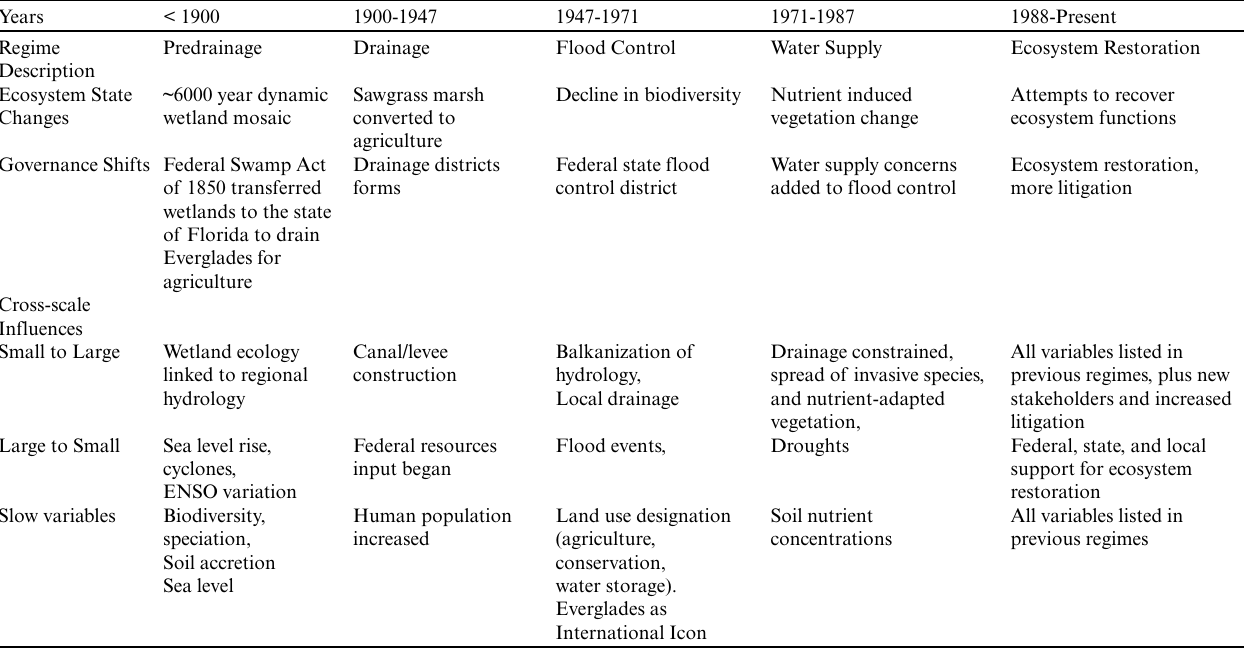
Table 5 . Resilience assessment of historical changes in the Florida Everglades. Situated in the southern portion of the Florida peninsula, the social-ecological system of the Everglades has undergone a series of transformations during the 20th century as indicated in the table below. Each transformation reflects a shift in the ecological components, social components, and/or governance regimes. At least five management regimes (Light et al. 1995) have been described, all of which were triggered by unforeseen environmental events or variation in hydrologic processes. Moreover, the transition among these different social-ecological configurations can be generally related to an erosion of system resilience. Such resilience is often linked to changes in slowly changing variables, either in the form of the loss of natural capital or increased vulnerability due to increasing forms of human